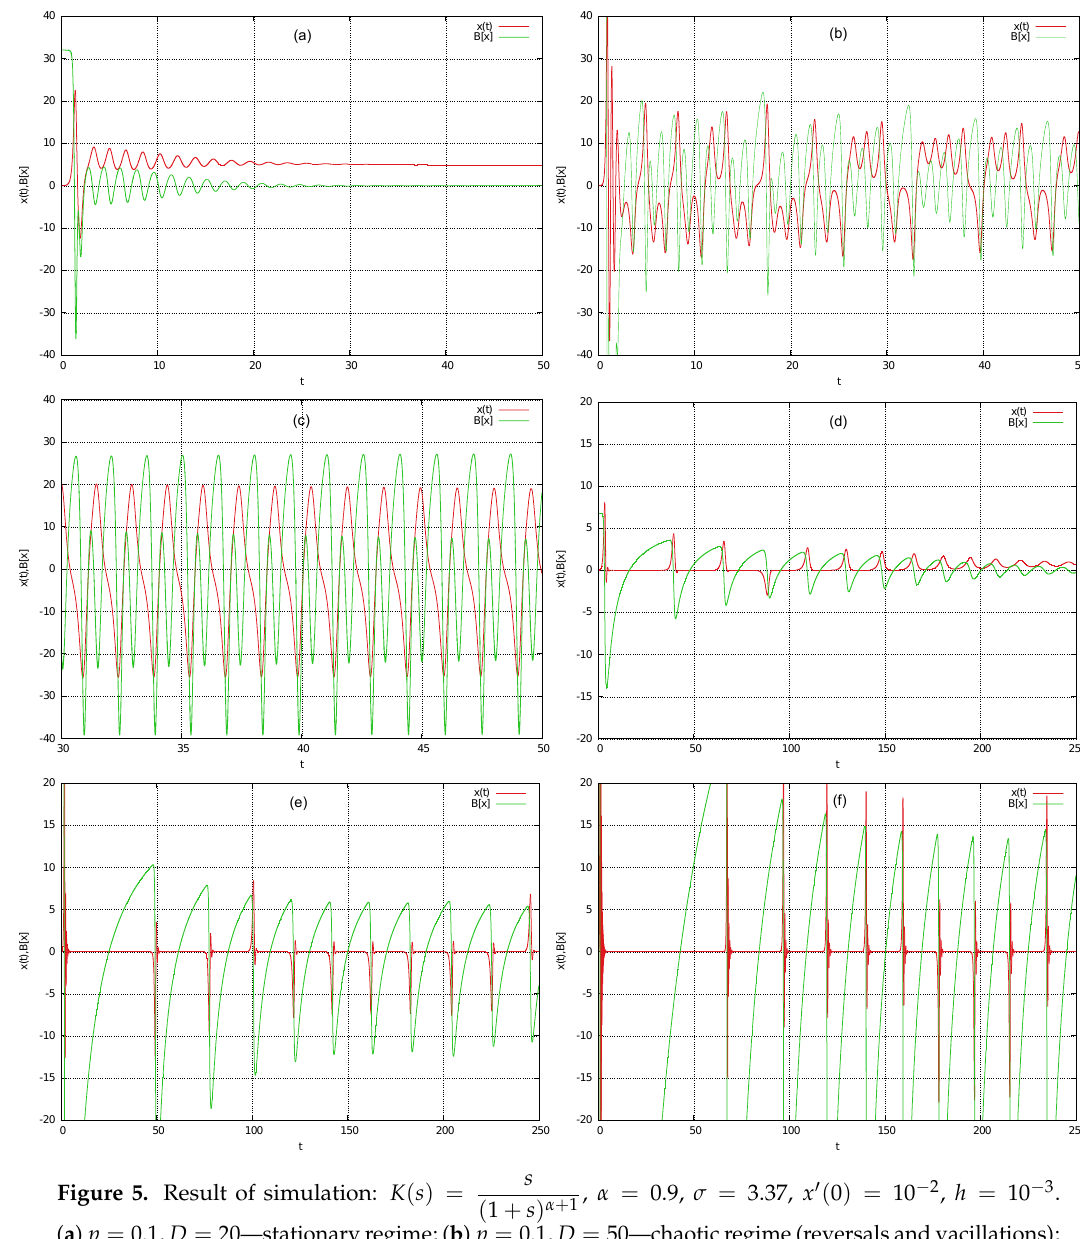
Figure 5. Result of simulation: K ( s ) =